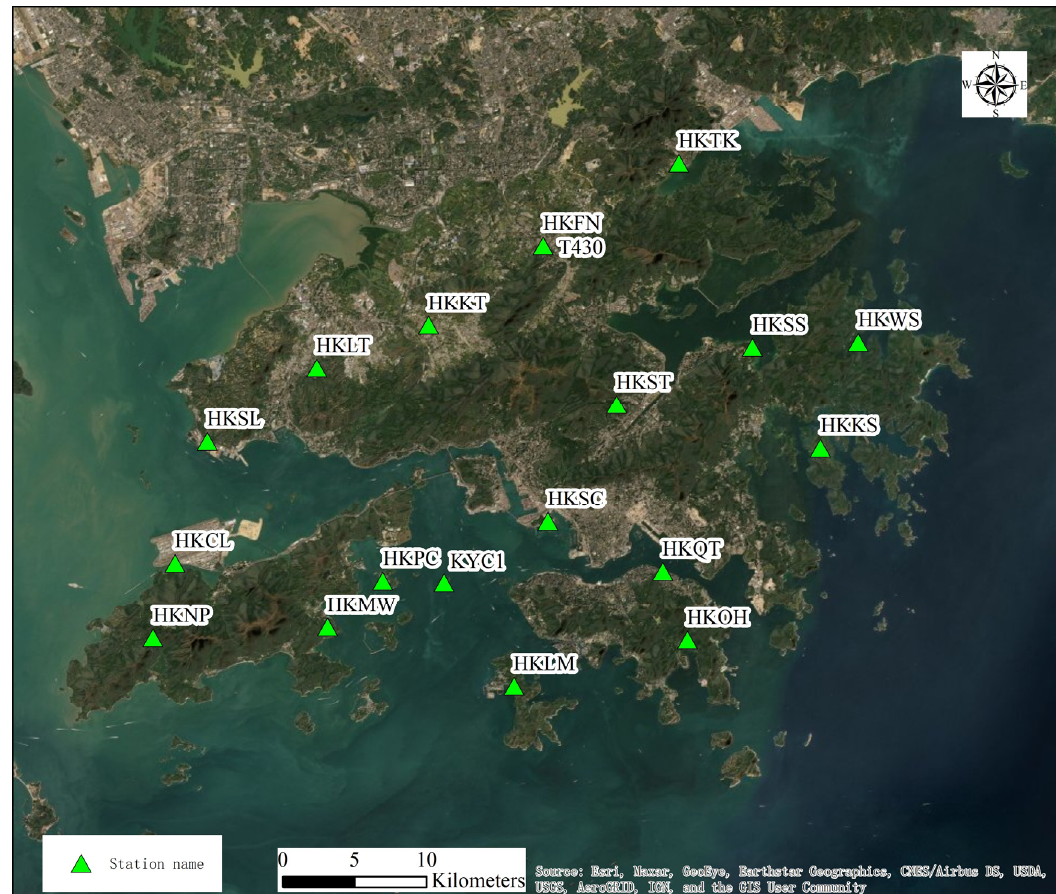
Figure 1. Station distribution of the Hong Kong Satellite Positioning Reference Station Network.